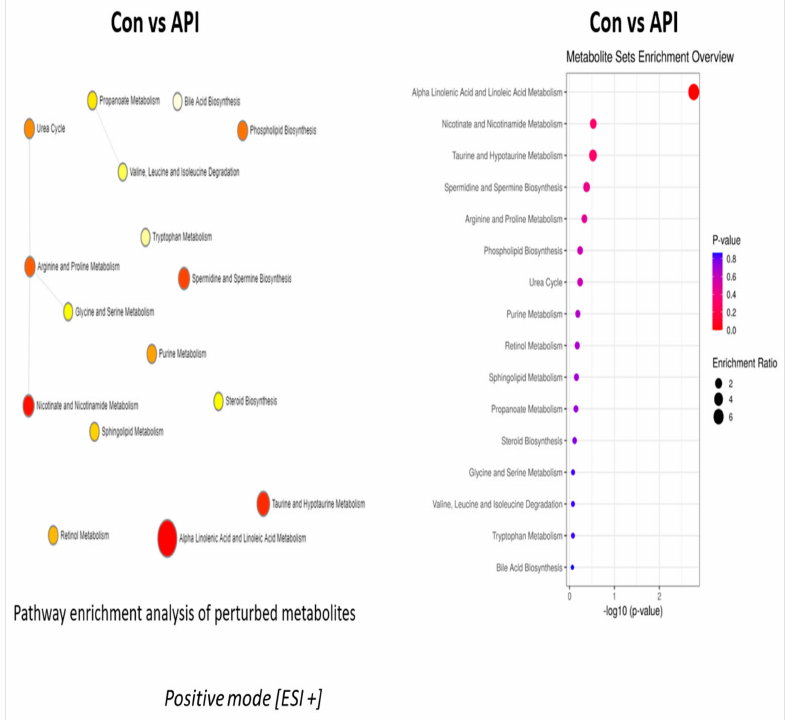
Figure 3. The figure depicts pathway enrichment analysis and the metabolic pathways that were significantly altered in positive ion mode following apigenin